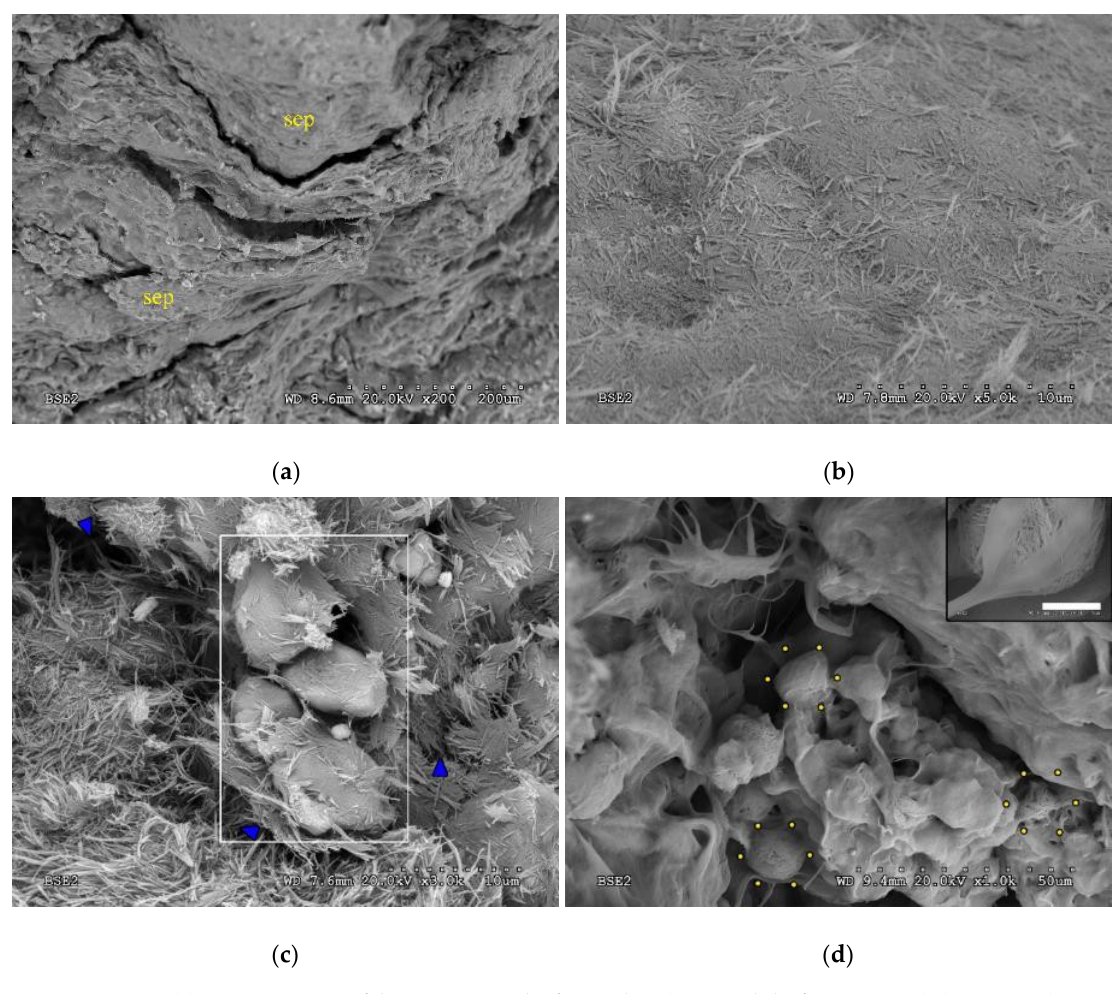
Figure 8. ( a ) Laminar microfabric composed of sepiolite (BS2I-9, lithofacies II.1-A) (SEM, BSE); ( b ) sepiolite surface showing densely interwoven fibres (BS2I-9, lithofacies II.1-A) (SEM, BSE); ( c ) sub-angular morphologies (unknown composition and origin) infilling pores in sepiolite (arrows)and coated by fiber aggregates (BS2I-12, lithofacies II.1-A) (SEM, BSE); and ( d ) lepispheres of opal C-T (dotted) showing sepiolite fiber coatings. Scale of close-up image is 5 µm length (BS2I-9, lithofacies II.1-A) (SEM, BSE).